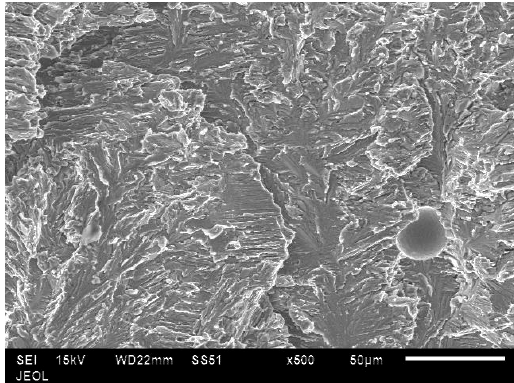
Figure 14. SEM fractograph showing cleavage type of fracture.